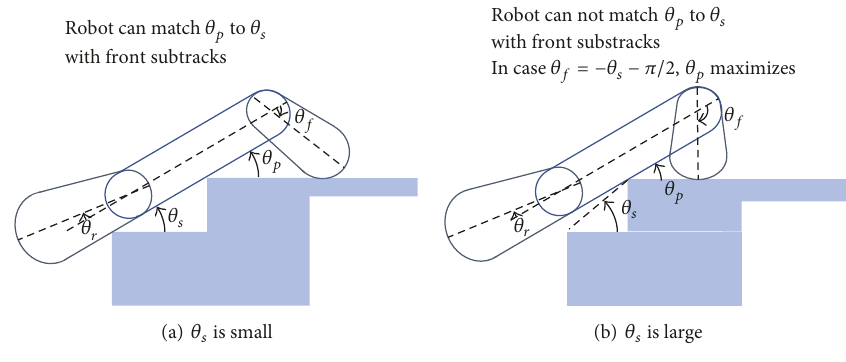
Figure 13: Pitch-up descend.